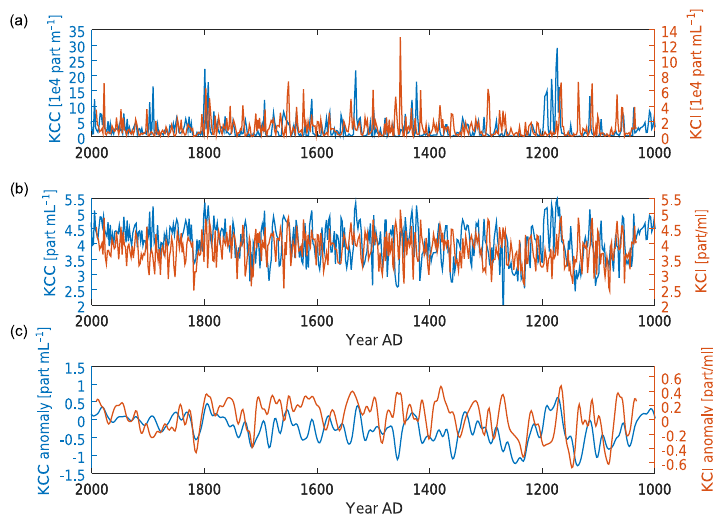
Figure 8. Inter-core comparison of the insoluble particle signal of KCC (blue) and KCI (orange): (a, b) show the insoluble particle time series on a linear and logarithmic scale, respectively; (c) shows decadal trends of anomalies with respect to their AD2000–1860 mean, highlighted by Gaussian smoothing. The KCI record is on the adjusted timescale after matching the stable water isotope records.